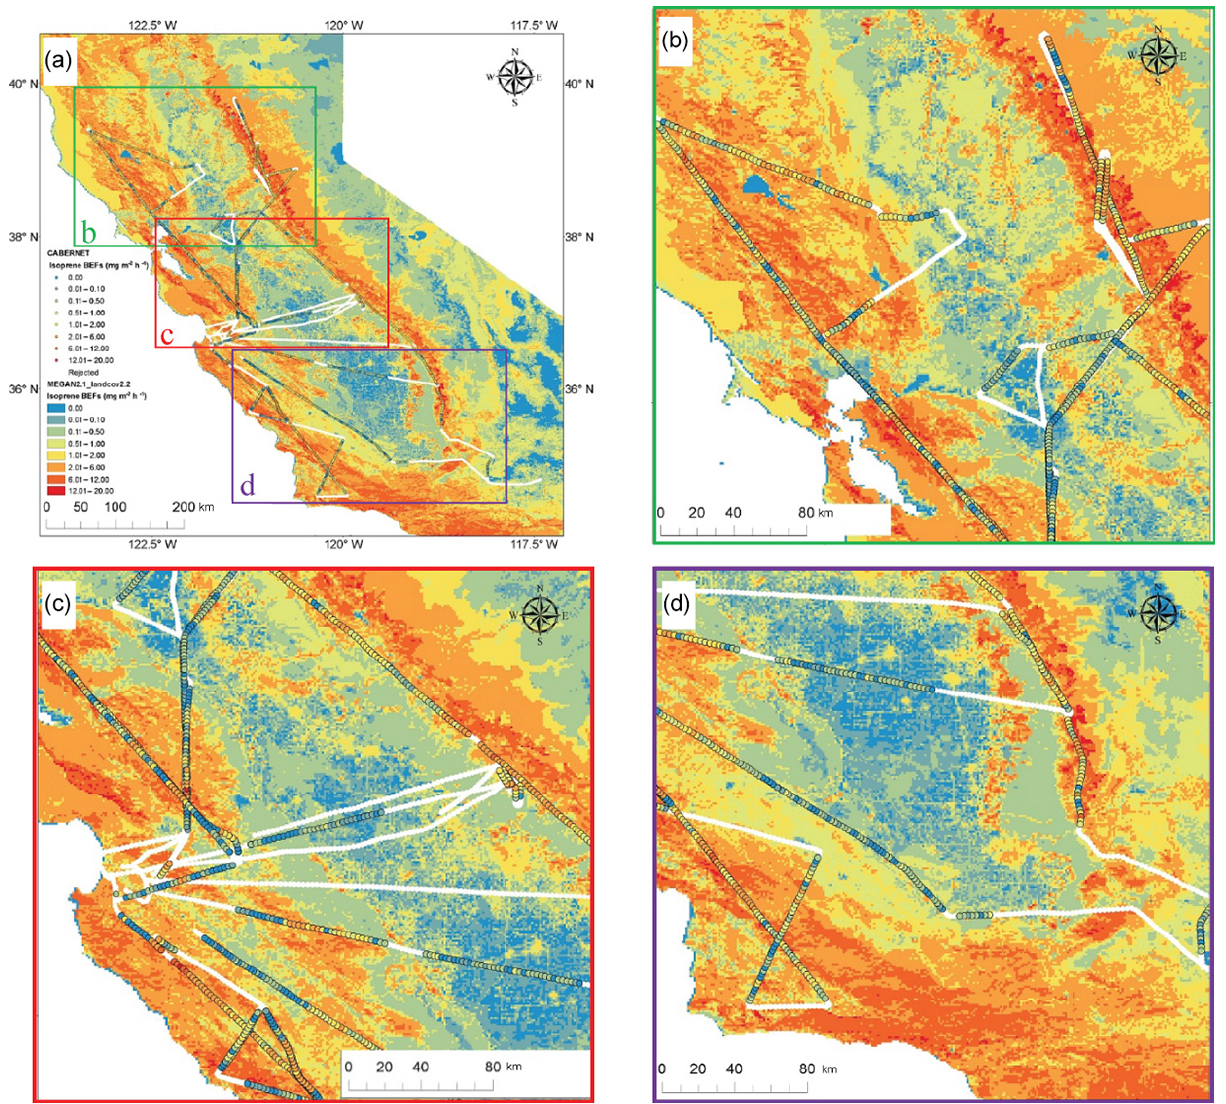
Figure 5. (a) Comparison of airborne BEFs with MEGAN’s land cover 2.2 for isoprene (airborne BEFs are subject to additional uncertainties introduced from T , and PAR used in normalization). Magnified areas are shown for (b) northwest (including the northern coastal ranges to the left and the northern Sierra foothills to the right, the middle area relates to the Central Valley and the San Joaquin delta), (c) central, and (d) southeast